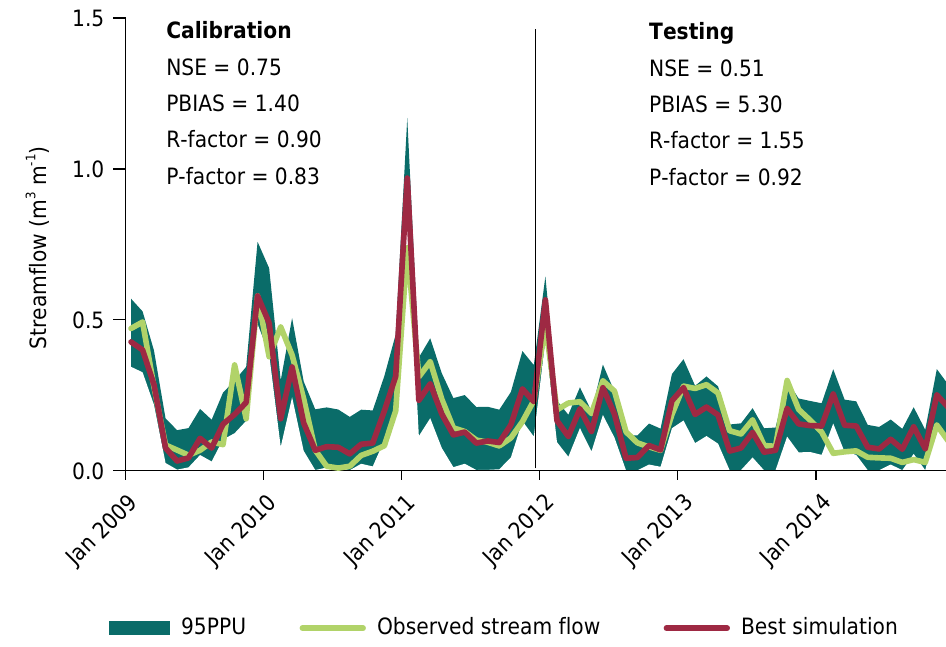
Figure 3. Observed and simulated monthly streamflow for calibration and testing periods with the evaluation indexes. Calibration period: January of 2009 to December of 2011; testing period: January of 2012 to December of 2014.